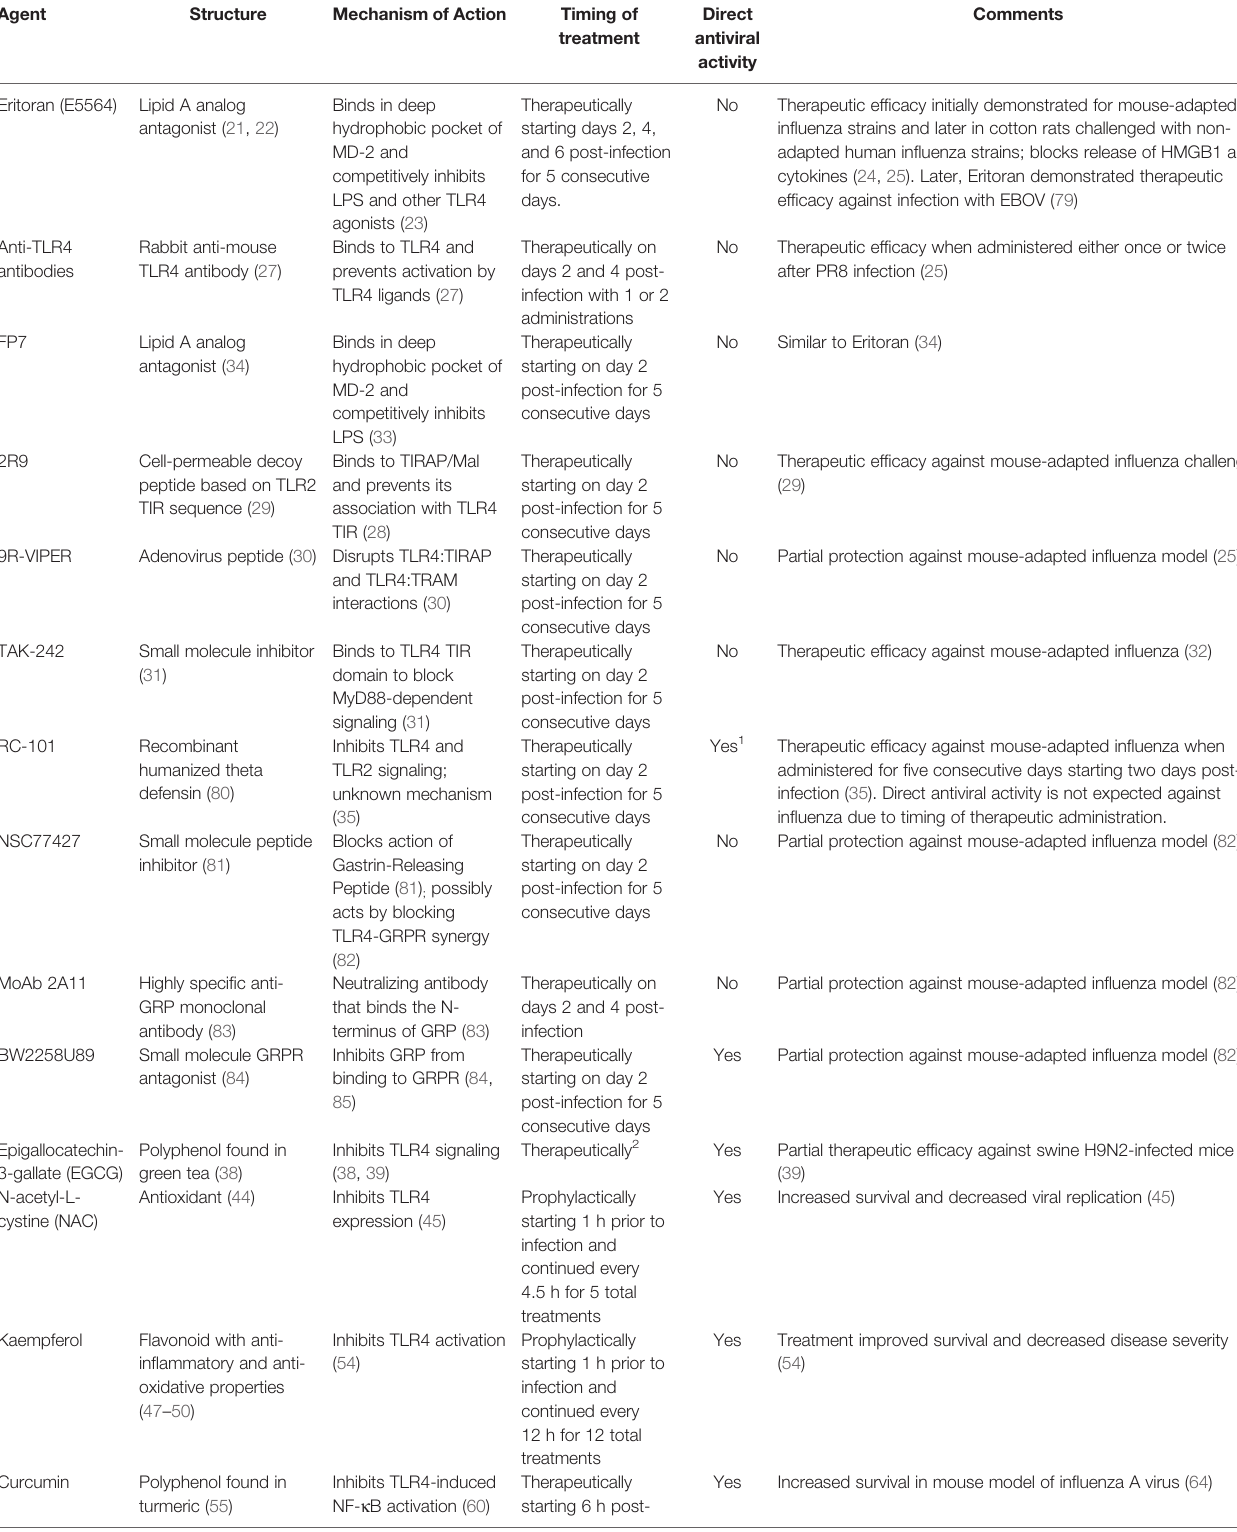
TABLE I | Summary of agents used to treat in fl uenza infection in rodent